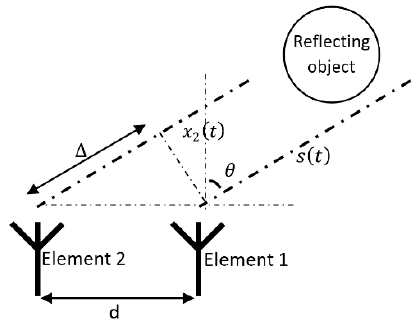
Figure 1. Configuration with a two-element receiving array.